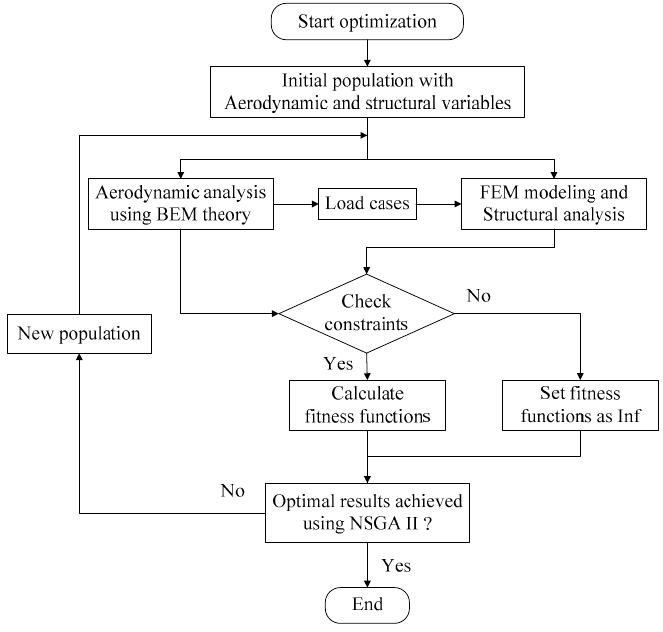
Figure 8. Flowchart of the optimization procedure.